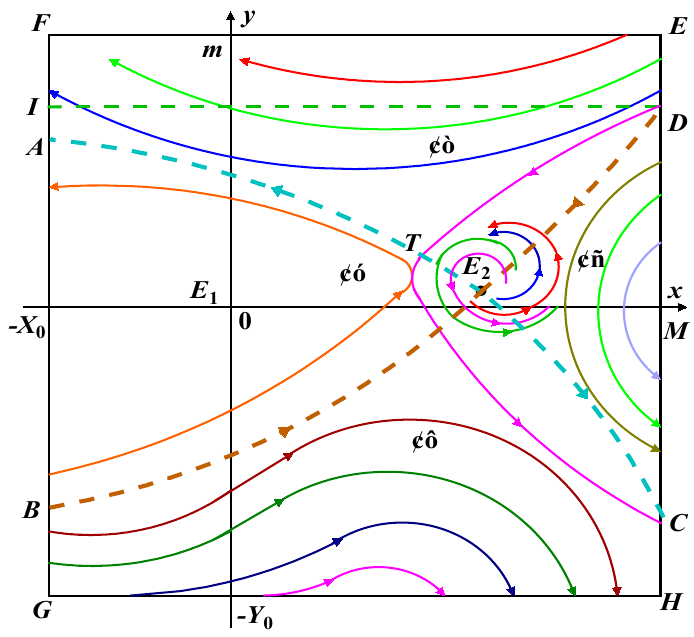
Figure 3. Unstable situation of the odd point E 2 ( u 0 , v 0